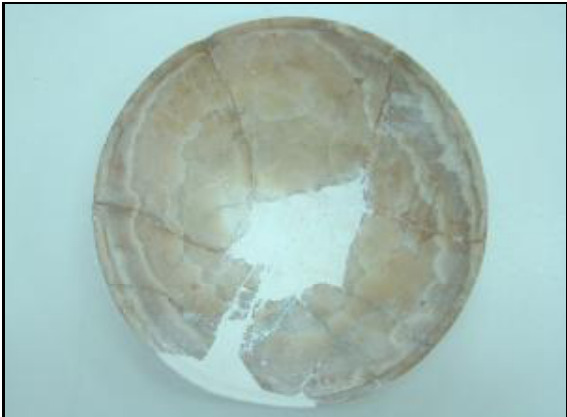
Figure 7: The selected Egyptian alabaster ’ s vessel after assembling, completion and all conservation